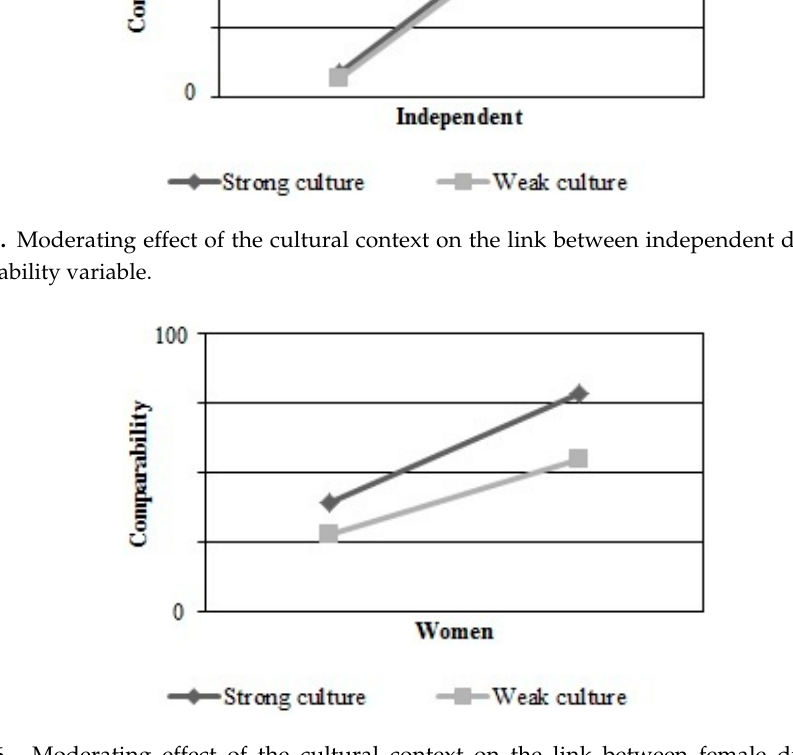
Figure 6. Moderating effect of the cultural context on the link between female directors and Comparability variable.